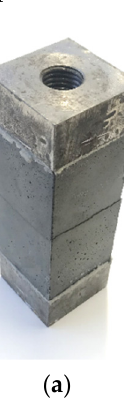
Figure 1. Test specimen for pullout tests: ( a ) Photo and ( b ) draft with typical dimensions in mm.